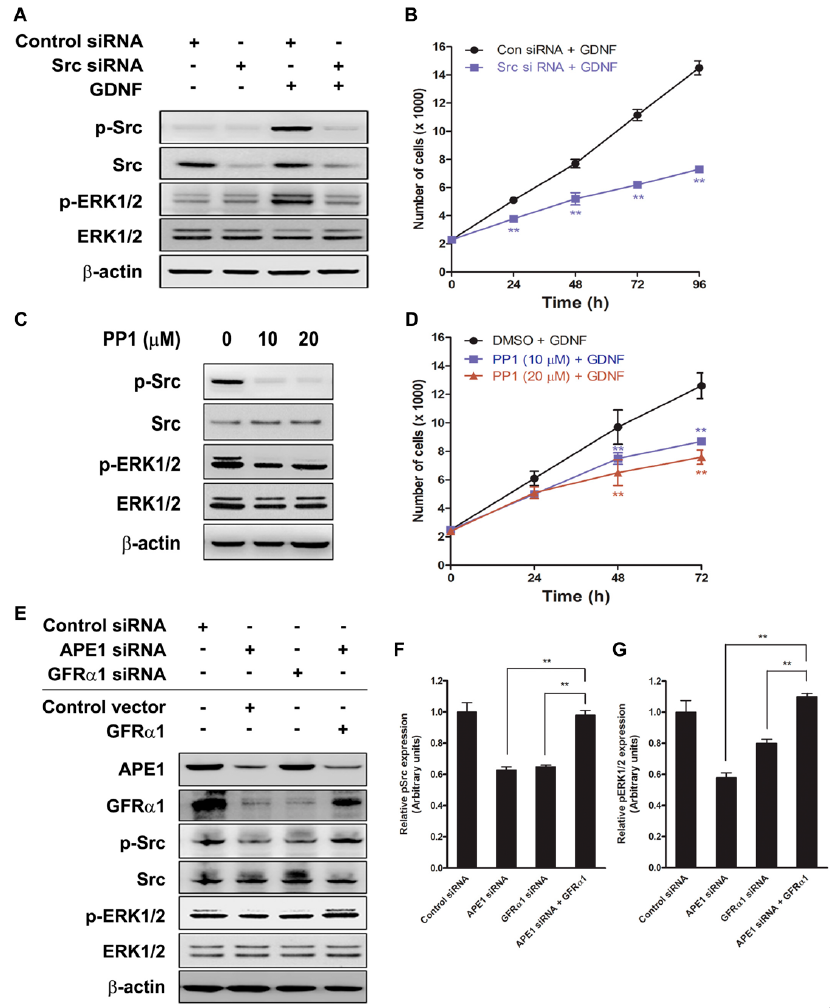
Figure 3. The role of APE1 on Src / ERK phosphorylation via GDNF / GFR α 1 signaling. ( A ) MIA PaCa-2 cells were transfected with control siRNA or Src siRNA. Forty-eight hours after transfection, cells were incubated with GDNF (50 ng / mL) for 1 h. Total cell extracts were prepared for immunoblotting with indicated antibodies. ( B ) Control or Src siRNA-transfected MIA PaCa-2 cells were incubated with or without GDNF (50 ng / mL) for up to 96 h. The number of cells was determined by counting the cells every 24 h after GDNF treatment. The values are represented as a mean ± standard deviation from three independent experiments. ** Denotes p < 0.01 by t -test for equality of means. ( C ) MIA PaCa-2 cells were treated with or without indicated amounts of PP1 and then incubated with GDNF (50 ng / mL) for 1 h. Total cell extracts were prepared for immunoblotting with indicated antibodies. ( D ) MIA PaCa-2 cells were treated with DMSO or PP1 and then incubated with or without GDNF (50 ng / mL) for up to 72 h. The number of cells was determined by BrdU assay every 24 h after GDNF treatment. The values are represented as a mean ± standard deviation from three independent experiments. ** Denotes p < 0.01 by t -test for equality of means. ( E – G ) MIA PaCa-2 cells were transfected with siRNA (control, APE1, or GFR α 1), and / or expression vectors (control or GFR α 1) and then incubated with GDNF (50 ng / mL) for 1 h. ( E ) Total cell extracts were prepared for immunoblotting with indicated antibodies. ( F ) Relative expression levels of p-Src were quantified by densitometry. The values are represented as a mean ± standard deviation from three independent experiments. ** Denotes p < 0.01 by t -test for equality of means. ( G ) Relative expression levels of pERK1 / 2 were quantified by densitometry. The values are represented as a mean ± standard deviation from three independent experiments. ** Denotes p < 0.01 by t -test for equality of